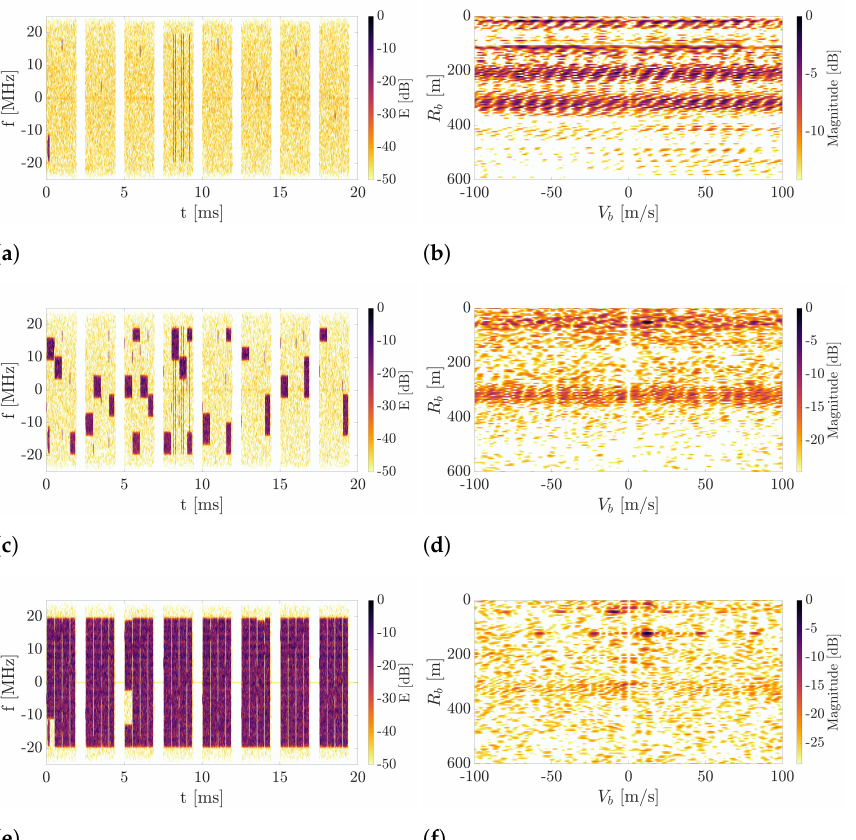
Figure 8. Example of spectrograms and CAFs for different amount of content in real-life 5G signal. Uplink part of the signal is blanked. ( a ) Spectrogram for no content. ( b ) CAF for no content. ( c ) Spectrogram for some amount of content. ( d ) CAF for some amount of content. ( e ) Spectrogram for almost full amount of content. ( f ) CAF for almost full amount of content.